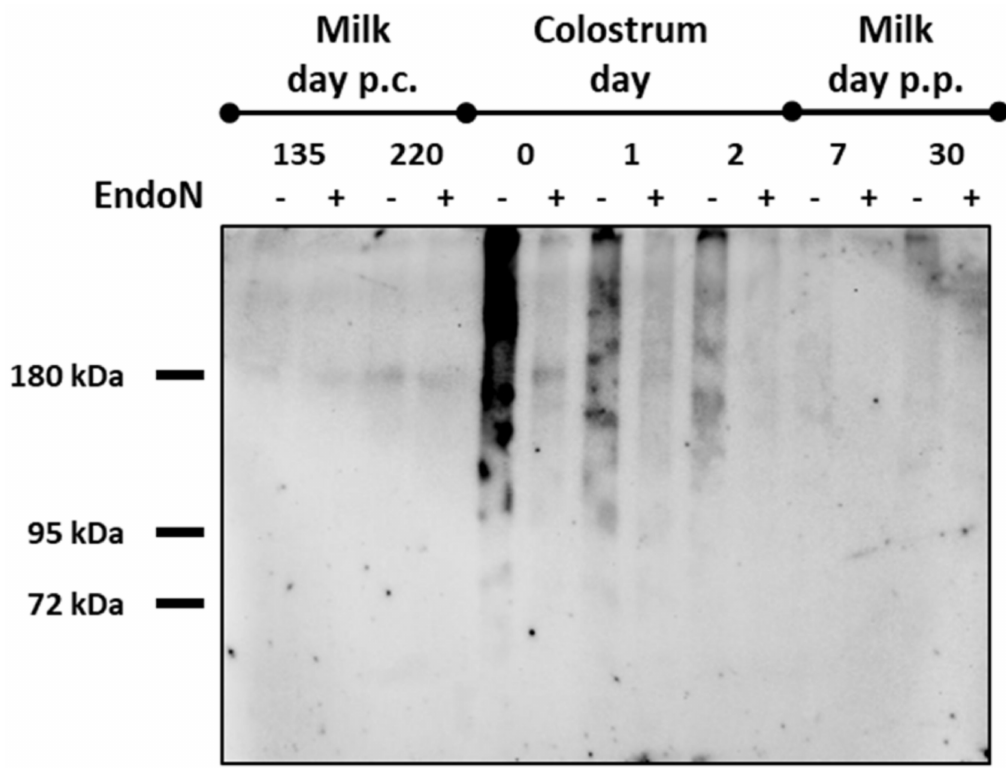
Figure 2. The polySia levels decrease during early lactation in the milk of dairy cows. PolySia was isolated from milk via magnetic beads, which were coated with inactive endoN. The eluates were used for Western blotting against polySia. Specific binding of mAb 735 was confirmed by pretreatment with endoN. PolySia contents in milk were analyzed at different time points of lactation. p.c. = post conception, p.p. = postpartum.